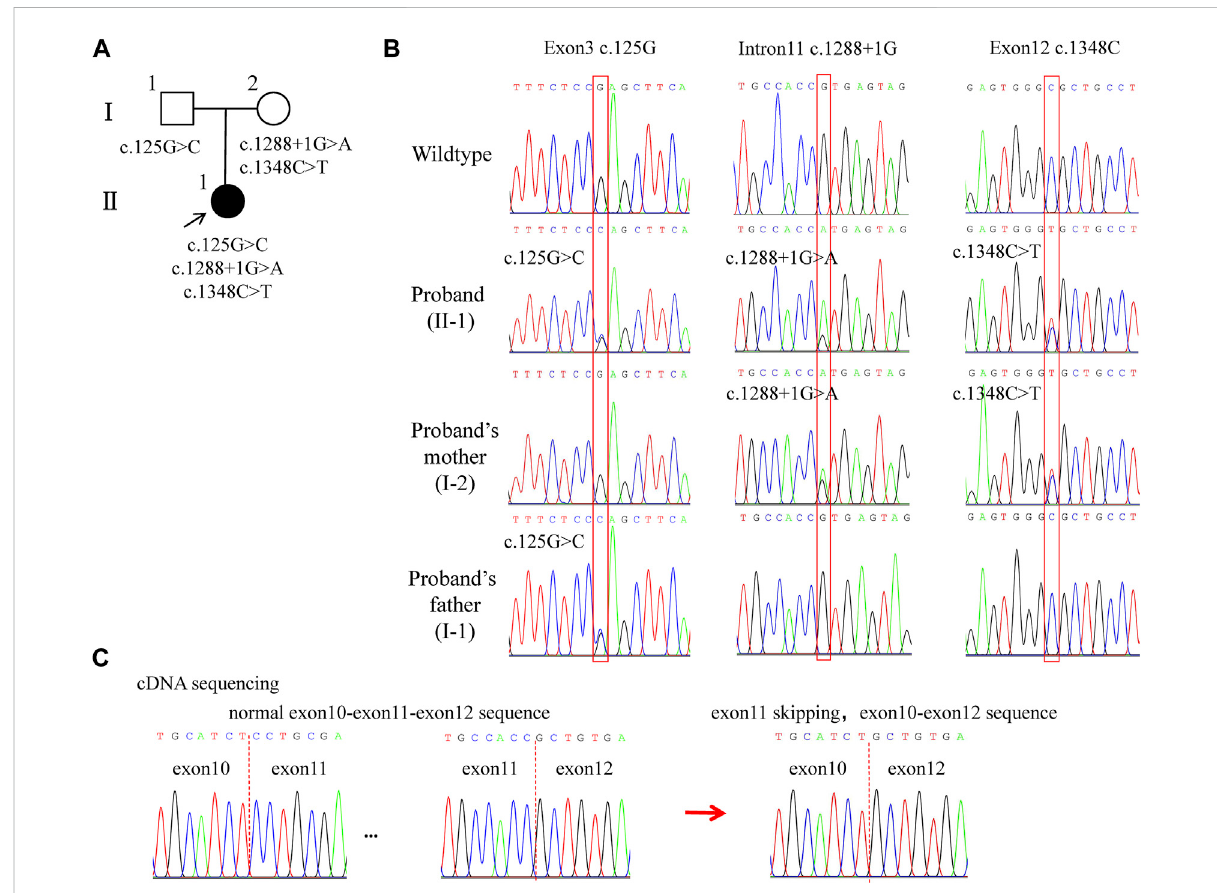
FIGURE 2 Pedigree and LAMB3 variants of the family. (A) Family pedigree. The black arrow indi-cates the proband. The solid black circle represents the patient. (B) Chromatograms showing heterozygous variants: c.125G > C, c.1288+1G > A, and c.1348C > T. (C) cDNA sequencing results showing the skipping of exon 11 after splicing. Red boxes indicate the mutational positions. Red dashed lines indicate the boundaries between